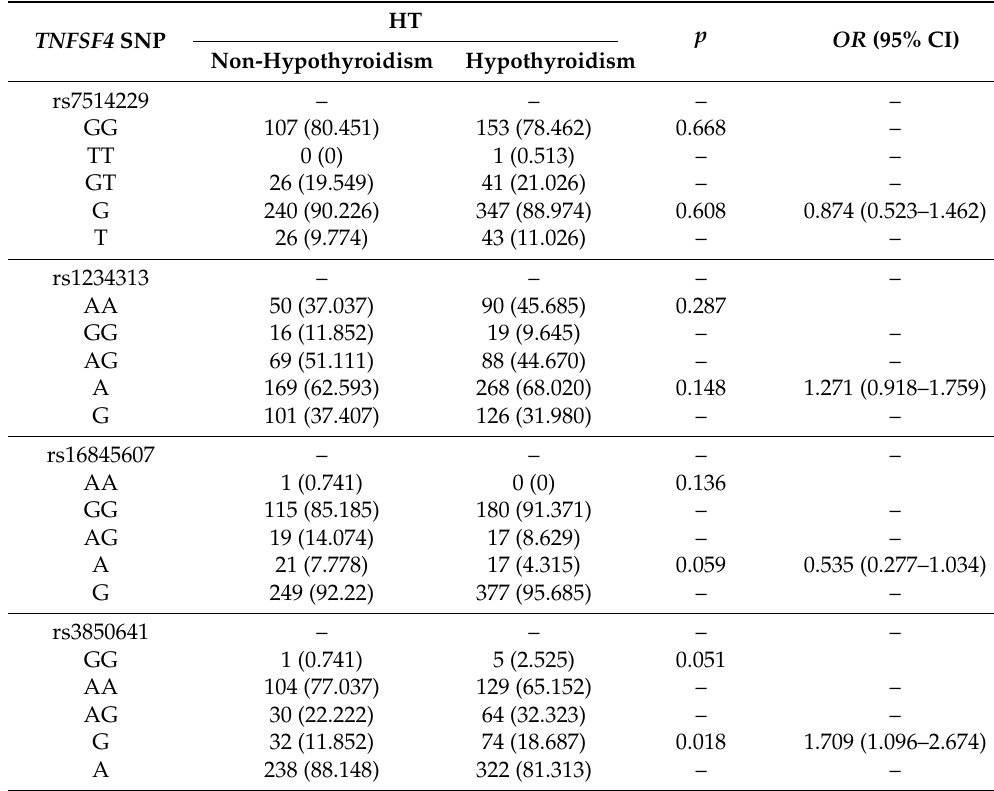
Table 6. TNFSF4 genotype and allele distribution in clinical sub-phenotype of HT